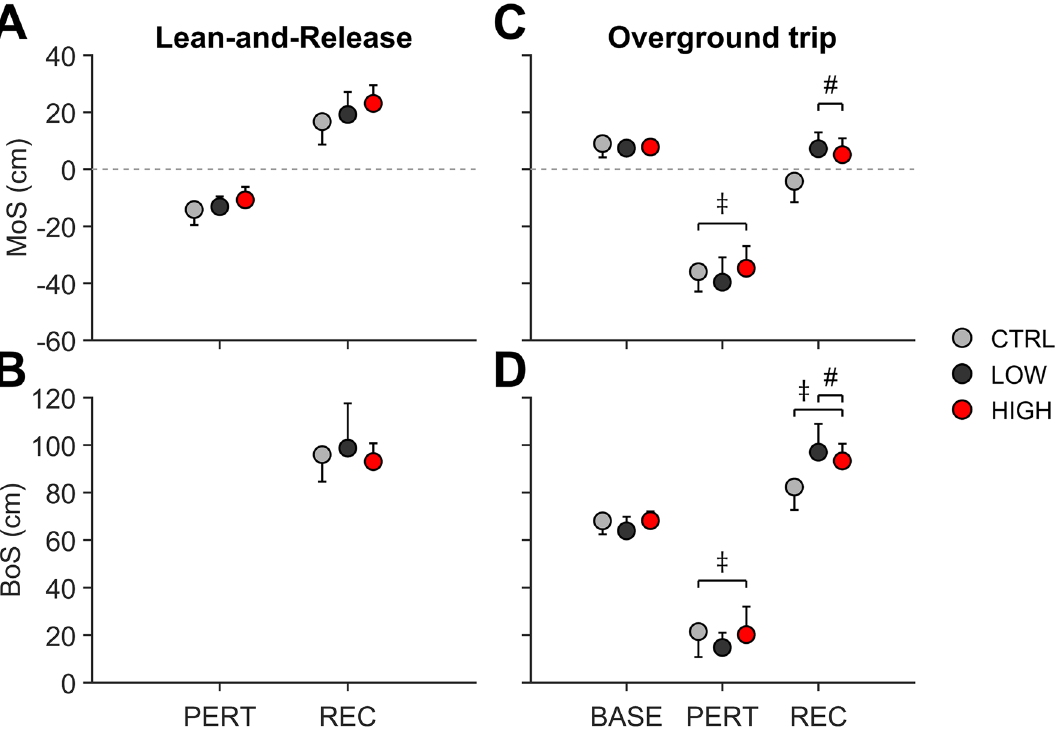
Figure 3. Margin of stability (MoS, A and C ) and base of support (BoS, B and D ) for the Lean-and-release and Overground trip transfer tasks for low ( n = 10) and high ( n = 10) perturbation magnitude groups and controls ( n = 10; CTR). Data is shown for cable release or left foot touchdown after gait perturbation (PERT) and subsequent right foot touchdown for recovery step (REC) for all groups and unperturbed baseline walking (BASE) only for the overground task. Note that the BoS at PERT for lean-and-release equalled zero for all groups and hence is not shown. Values are presented as averages with standard deviation error bars. ‡ and # indicate significant differences. ‡ vs. BASE ( P < 0.001); # vs. CTR ( P <